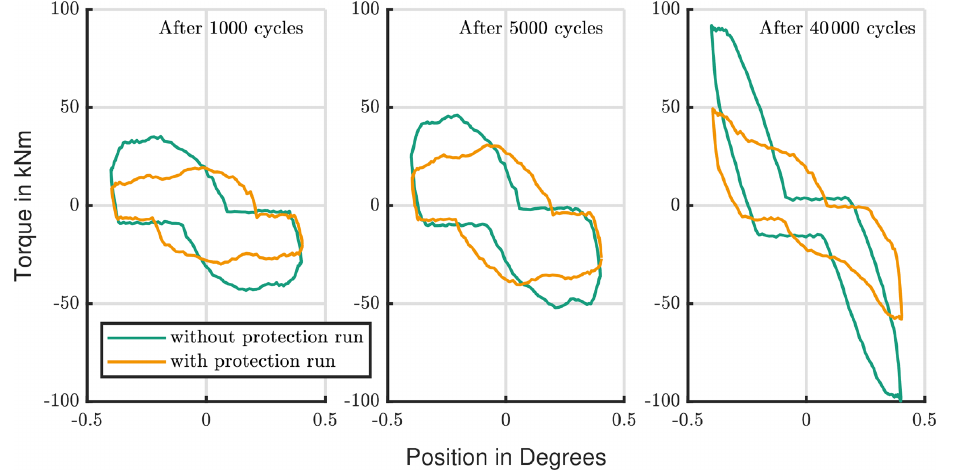
Figure 16. Torque development: comparison of the protection run and reference test.